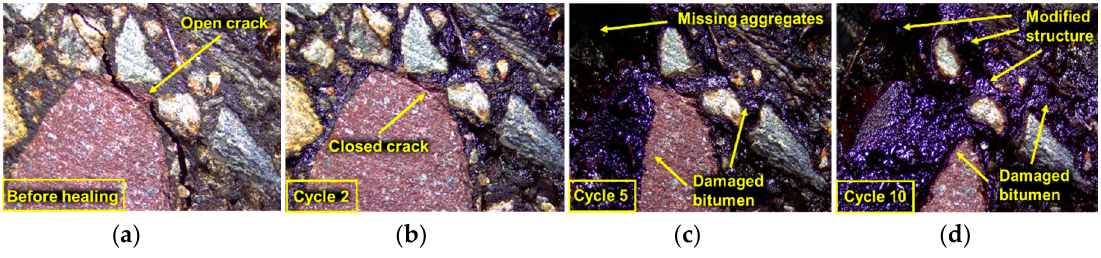
Figure 7. Optical microscope images of the crack produced on an asphalt sample with 4% of fibres, in different stages of the cyclic healing process: ( a ) before healing; ( b ) after the 2nd healing cycle; ( c ) after the 5th healing cycle; ( d ) after the 10th healing cycle. Image dimensions are 8 × 10 mm, approximately.